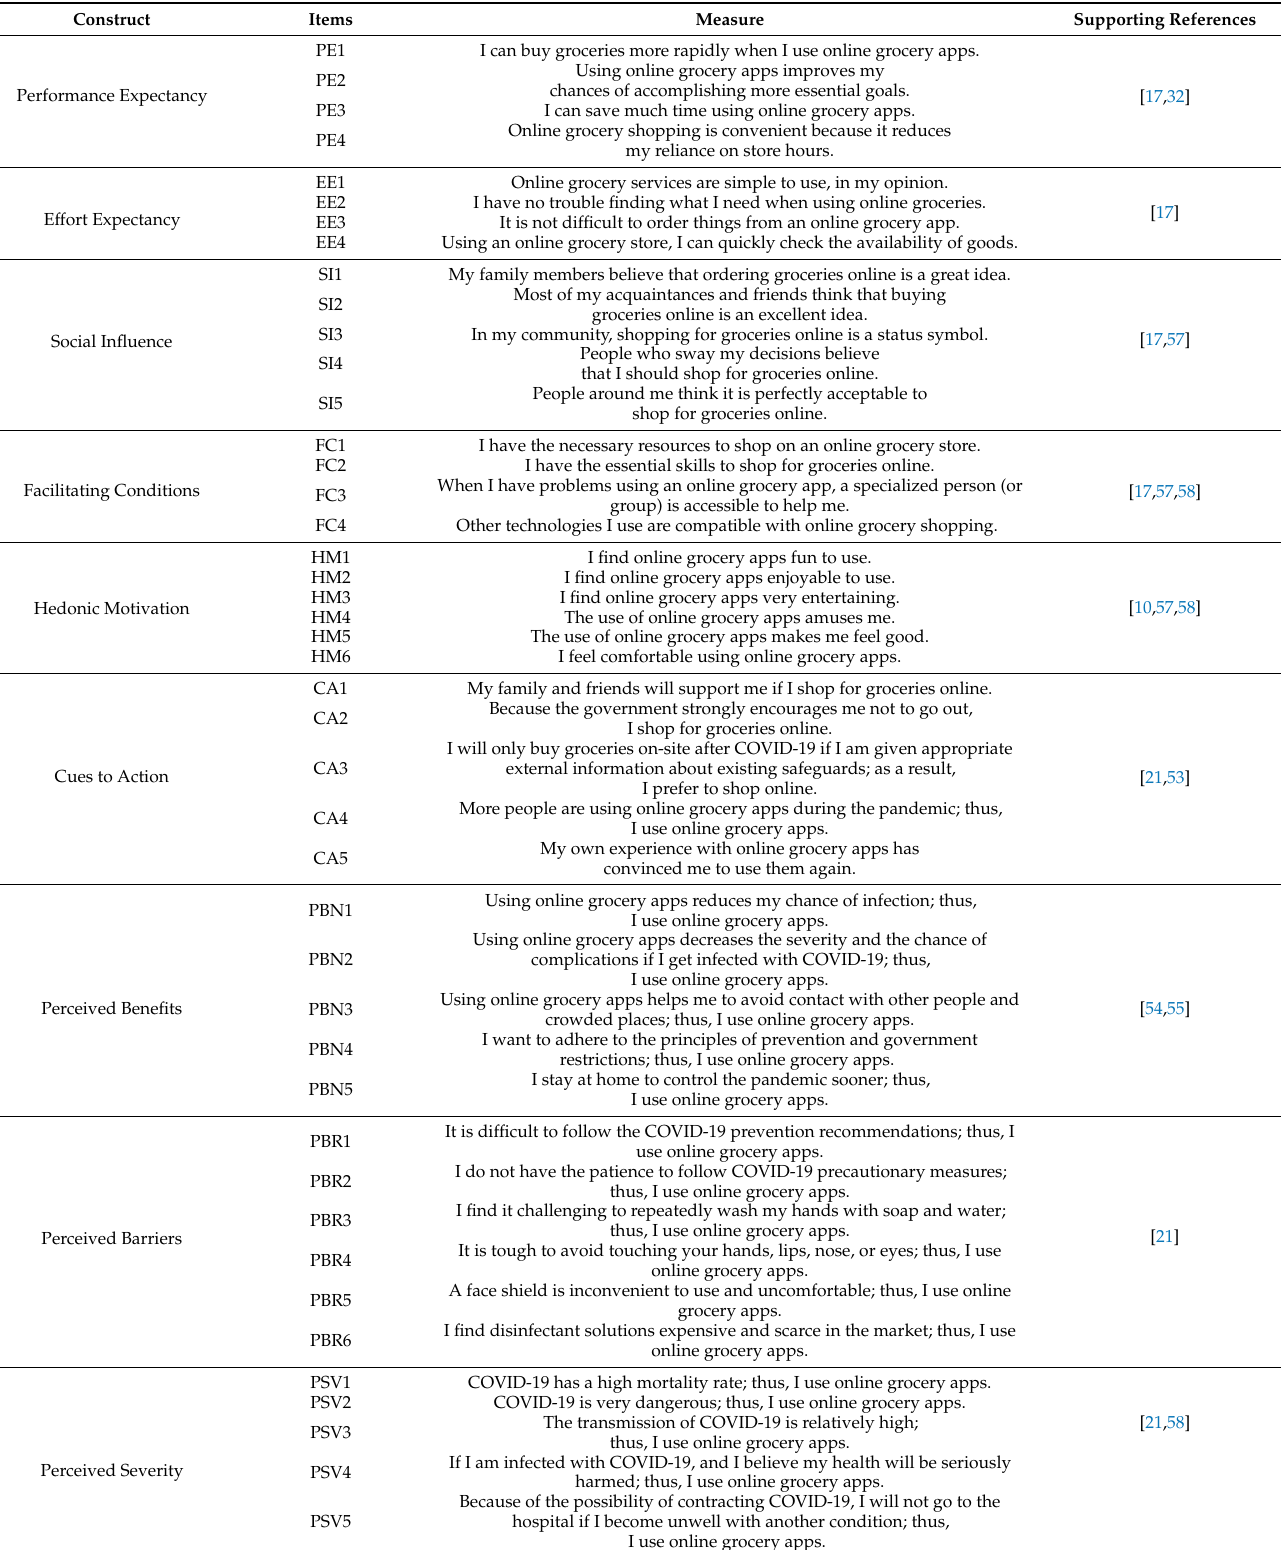
Table 4. The construct and measurement